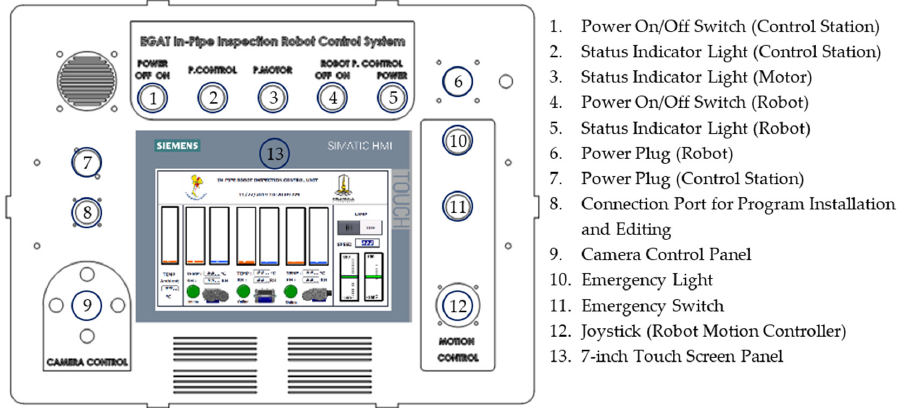
Figure 11. A diagram of the camera display panel.